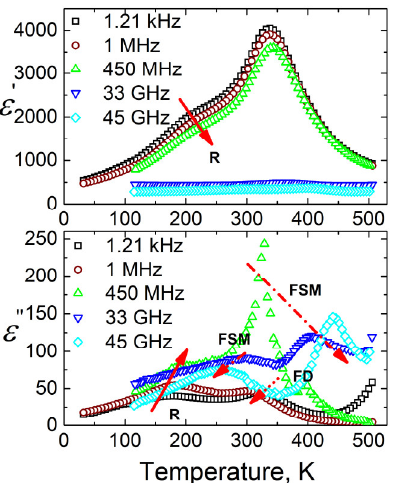
Figure 3. Temperature dependence of the real and the imaginary parts of complex dielectric permittivity ε* = ε’ − i ε” for Ba 0.83 Ca 0.17 TiO 3 ceramics measured at several frequencies (R—relaxor, FSM—ferroelectric relaxational soft mode, FD—ferroelectric domains related dielectric dispersions).